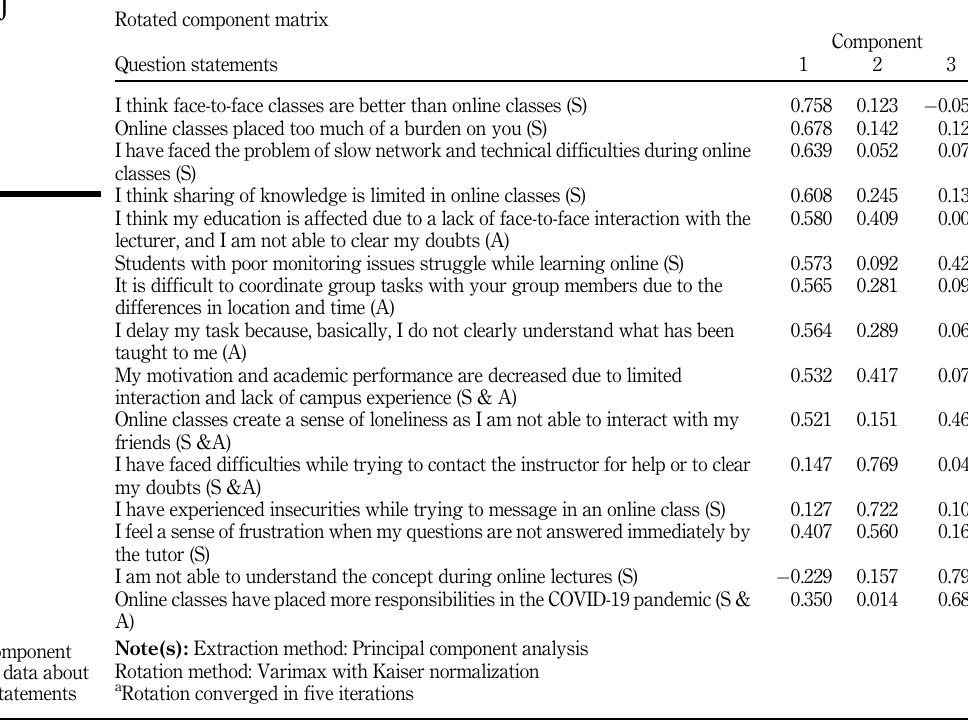
Table 3. Rotated